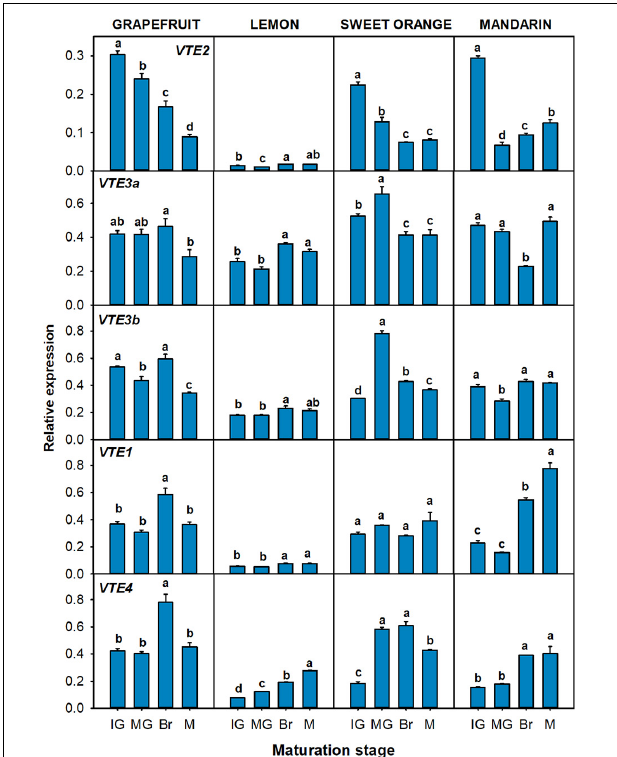
FIGURE 7 | Relative expression of genes of the tocopherol-core pathway in the pulp during fruit maturation of grapefruit ( C. paradisi ), lemon ( C. limon ), sweet orange ( C. sinensis ), and mandarin ( C. clementine ). The genes analyzed were VTE2 (HPT, homogentisate phytyl transferase), VTE3a and VTE3b (MPBQ-MT, 2-methyl-6-phytyl-1,4-benzoquinol methyltransferase a and b), VTE1 (TC, tocopherol cyclase), and VTE4 ( γ -TMT, γ -tocopherol methyltransferase). Maturation stages correspond to immature green (IG), mature green (MG), breaker (Br), and mature (M). The data are mean ± SE of at least three replicates ( Supplementary Table 12 ). Different letters indicate significant mean differences among maturation stages for each fruit specie (Tukey’s test, p ≤